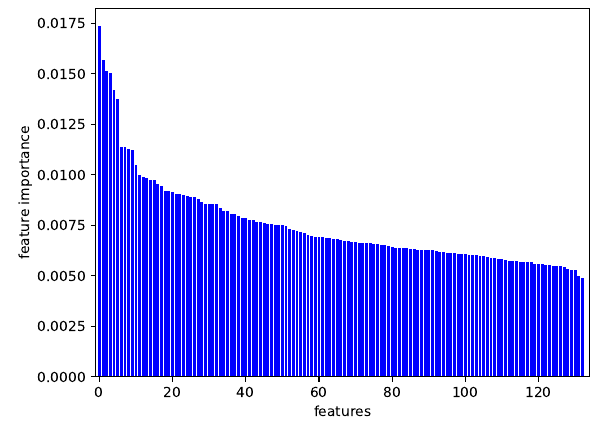
Figure 3. Feature importance.